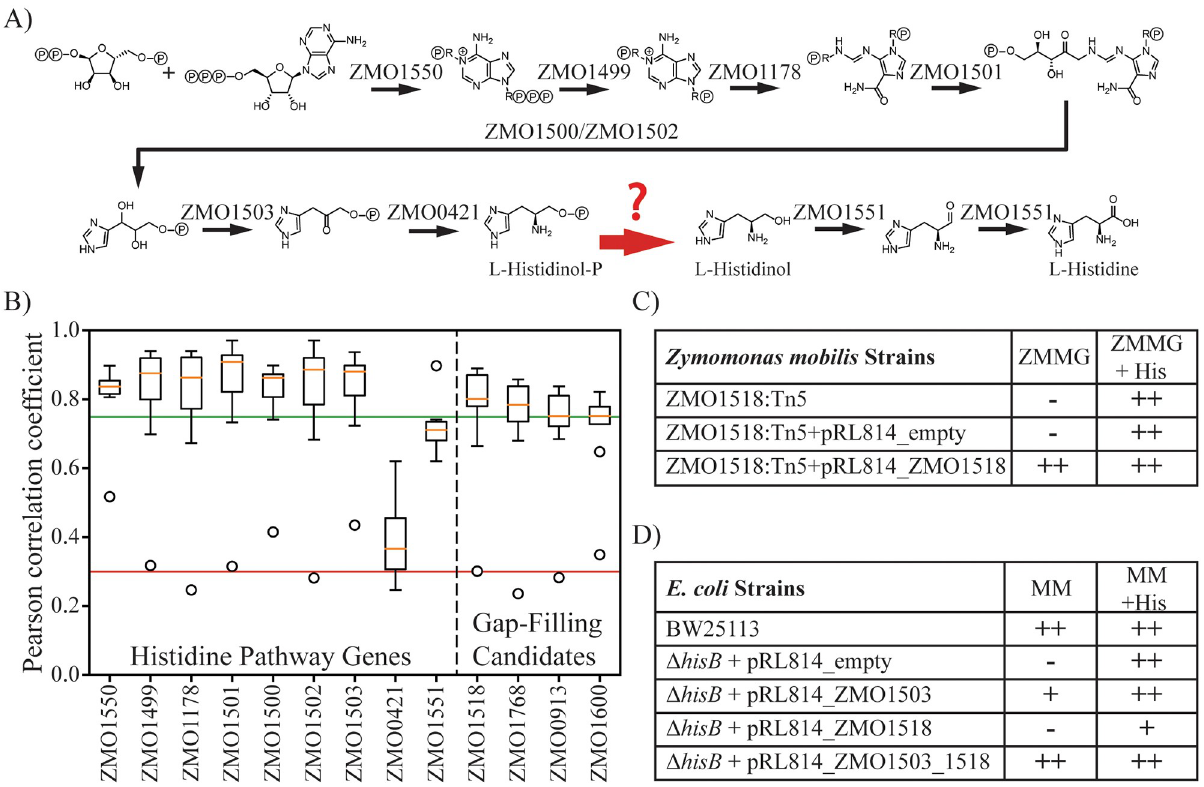
Fig 3. Identification of the histidinol-phosphatase gene. (A) An overview of the histidine biosynthesis pathway, converting 5-phosphoribosyl diphosphate (PRPP) to L-histidine. Note that ZMO1500 and ZMO1502 are subunits associated with the same reaction. Highlighted in red is the gap- filled histidinol-phosphatase reaction lacking an annotated gene. (B) Boxplot of the cofitness values for genes with known histidine biosynthesis genes. Cofitness of the genes in the histidine pathway with the eight genes of the histidine pathway are shown on the left. Candidate genes for the histidinol- phosphatase reaction (i.e., those with the highest average cofitness to the known genes) are shown on the right. The low cofitness outlier in all cases (except ZMO1551) corresponds to the cofitness with the ZMO0421 gene. (C) Growth experiments showed the ZMO1518::Tn5 mutant was a histidine auxotroph that could be rescued by complementation with ZMO1518 on a plasmid. Phenotypes are categorized as growth (++), weak growth (+), and no growth (-). (D) Growth experiments in E . coli Δ hisB demonstrate that ZMO1518 encodes a histidinol-phosphatase. Note that in E . coli , hisB has two functions catalyzing both the sixth and eighth steps in histidine biosynthesis, and therefore the E . coli Δ hisB knockout requires complementation with both ZMO1503 and ZMO1518.